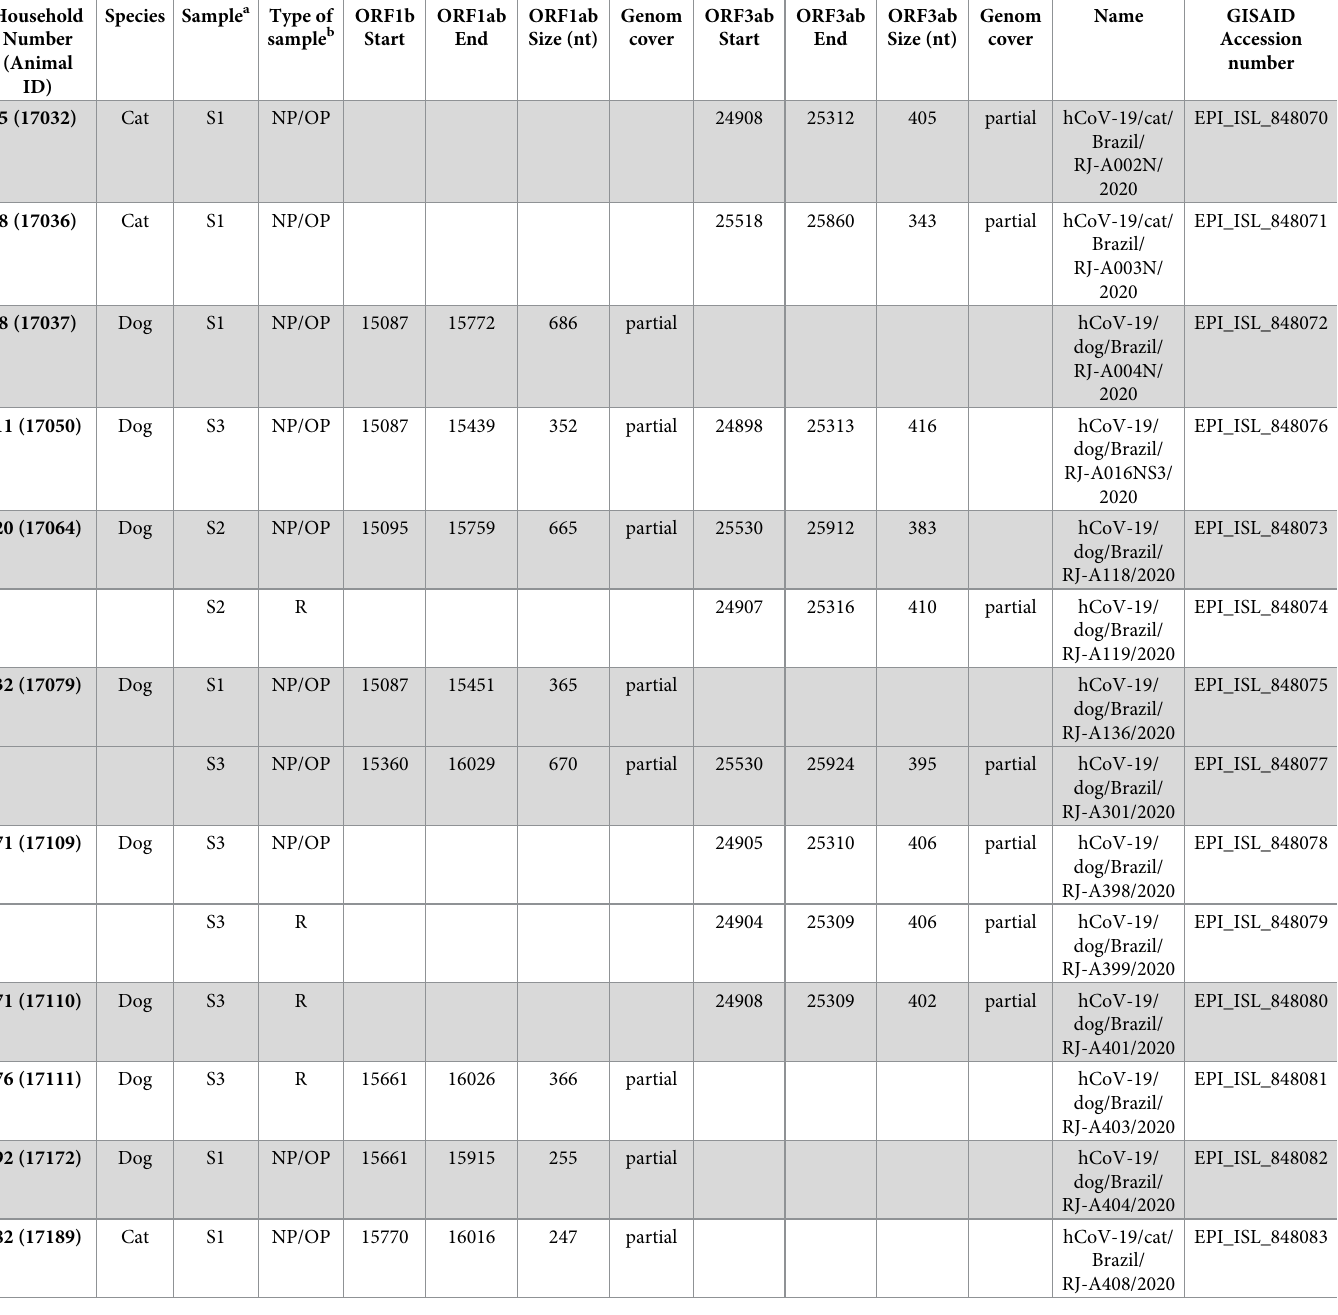
Table 2. Fragment size (nucleotides) and position according to the reference strain SARS-Cov-2 (19/Wuhan/WIV04/2019 (WIV04) (EPI_ISL_402124)) of virus obtained from animals in the present study. Household